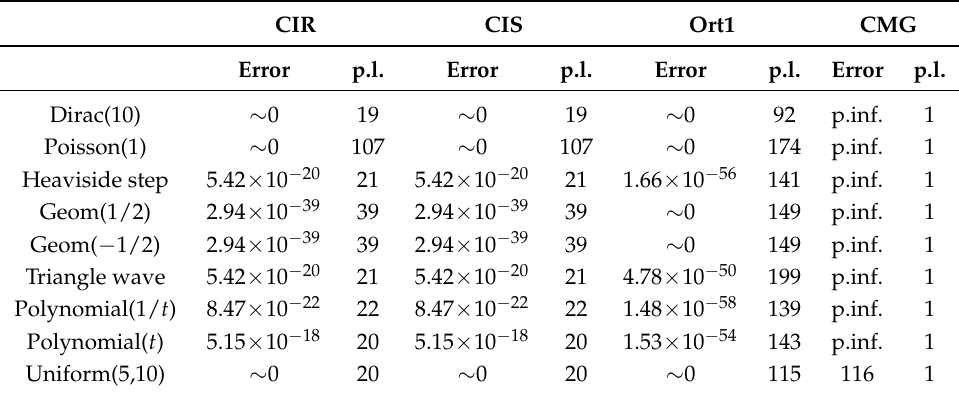
Table 5. Error and precision loss for various test functions ( N = 64, T max = 32, a = 2).